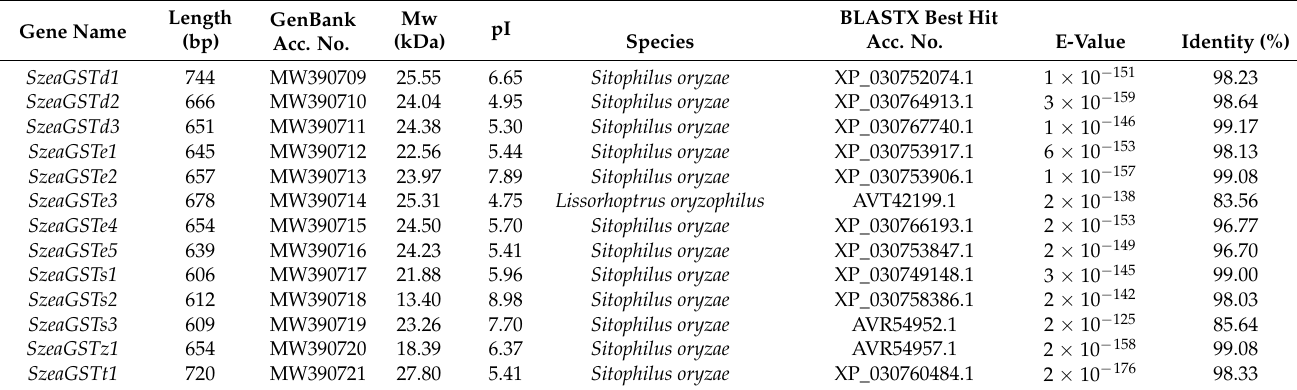
Table 1. Summary of the GST genes identified in Sitophuls zeamais